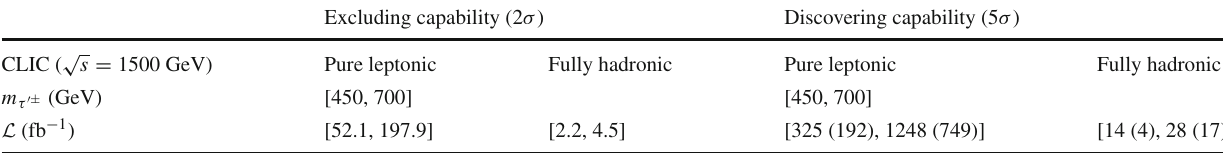
Table 14 Same as Table 12 but for